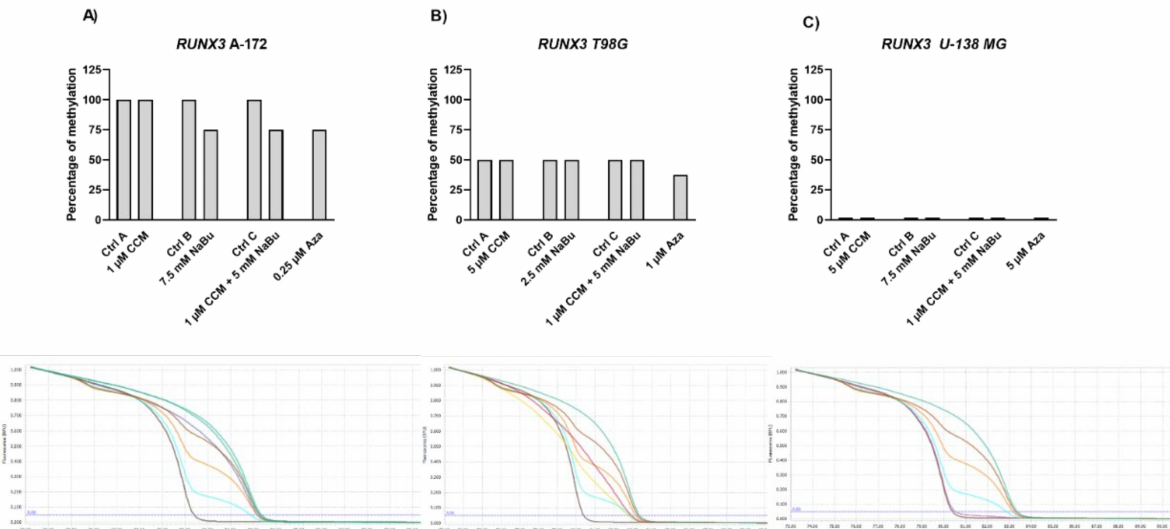
Figure 9. Results of MS-HRM analysis with representative melting curves of RUNX3 promoter methylation in A-172 ( A ), T98G ( B ), and U-138 MG ( C ) cell lines. Cells treated with vehicle (DMSO, PBS or both) are designated as Ctrl A, Ctrl B, and Ctrl C, respectively. Due to semiquantitative nature of generated results, no SEM bars are shown. Below each bar chart melting curves of control and best demethylating compound/combination is presented, together with subsequent controls: 100%, 75%, 50%, 25%, and 0% methylated controls (upper green, brown, honey-yellow, blue, and dark brown, respectively). For A-172 cell line, melting curve generated after treatment with 1 µ M CCM + 5 mM NaBu mix is presented (blue line) regarding Ctrl A (green line, below 100% methylated DNA). For T98G cell line, Aza is presented (fair yellow) regarding Ctrl A (red). In case of U-138 MG cell line, only Ctrl A is presented (pink), reflecting no DNA methylation in analyzed region.